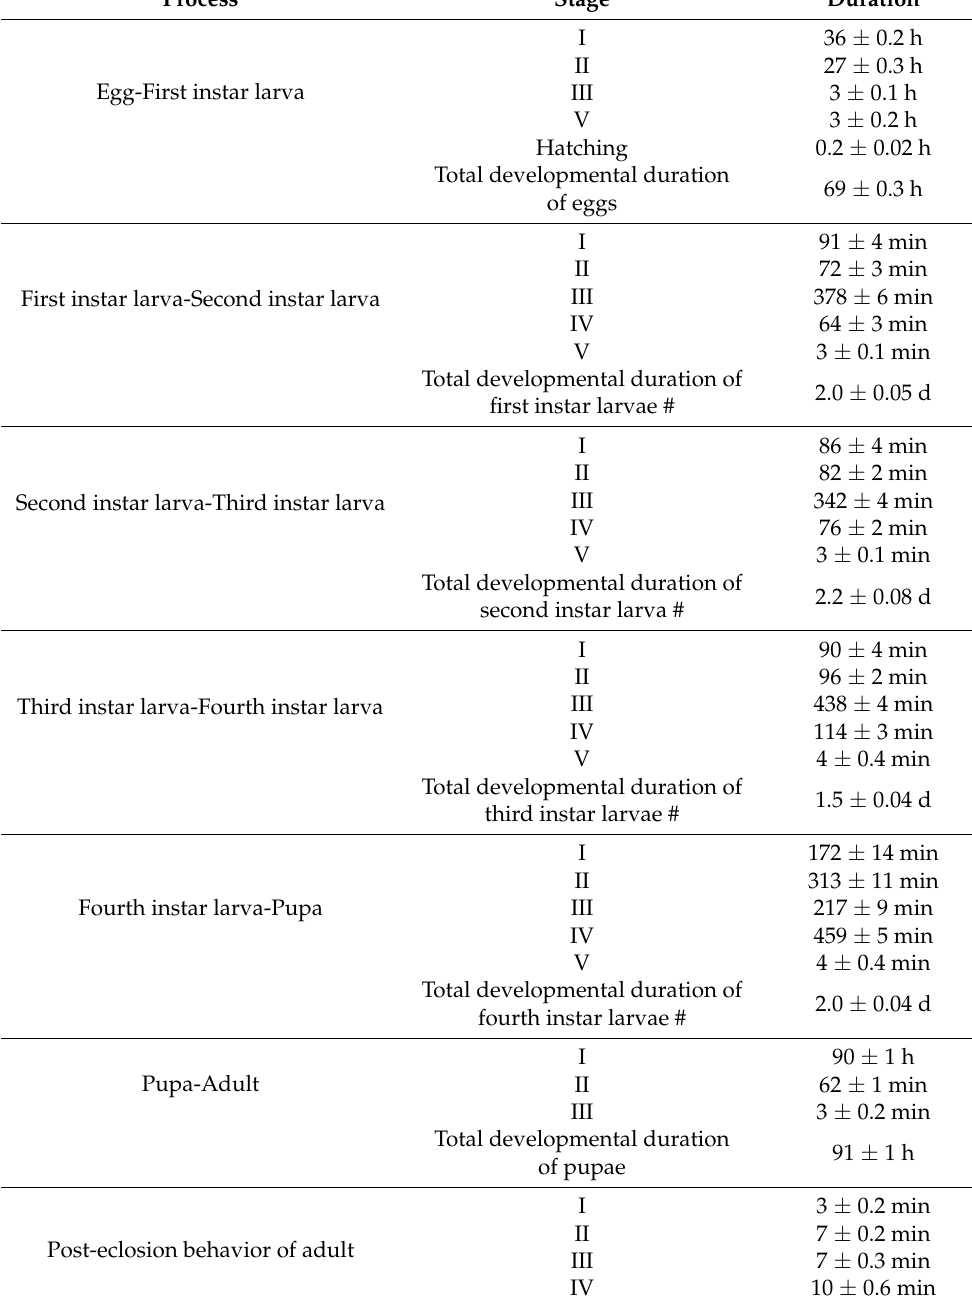
Table 1. Timetable of each stage of the molting process during the different developmental stages of Plutella xylostella . The durations are presented as means ± s.e.m. n = 33 in egg to first instar larva and first to second instar larva. n = 38 in second to third instar larva. n = 53 in third to fourth instar larva. n = 36 in fourth instar larva to pupa, pupa to adult, and post-eclosion behavior of adult. # indicates the data from Liu et al. (2002)